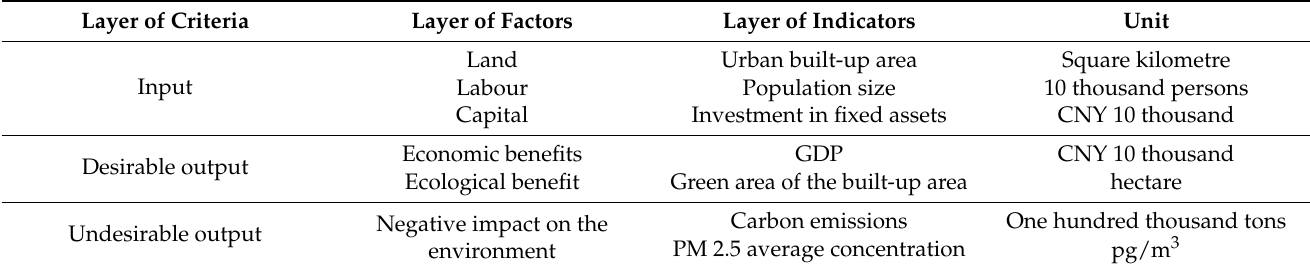
Table 1. Index system for measuring the